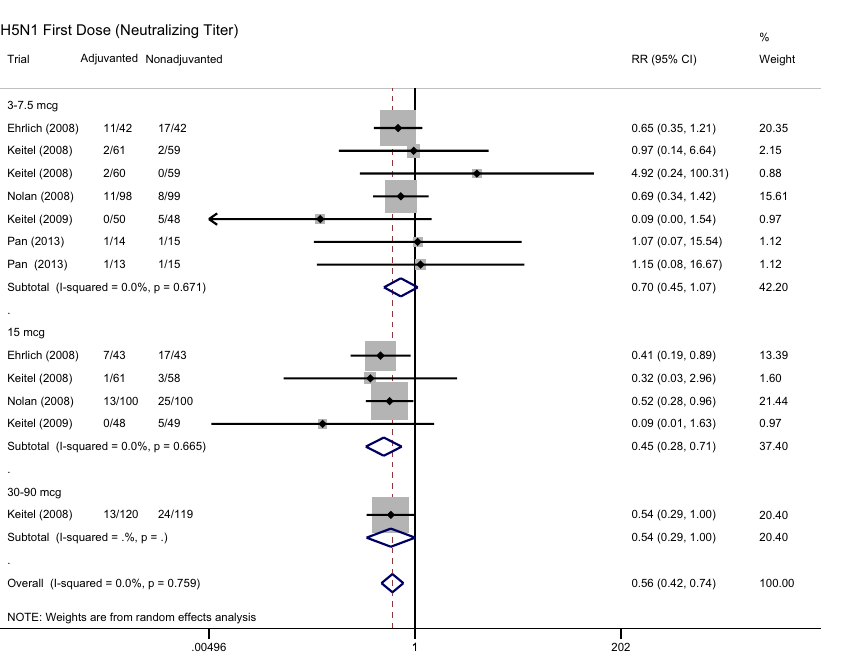
Figure 3. Forest plot showing the ratio of the seroprotection rate by neutralization antibody assay, 21–28 days after the first dose of H5N1 vaccines in participants who received aluminum-adjuvanted vaccines versus non- adjuvanted